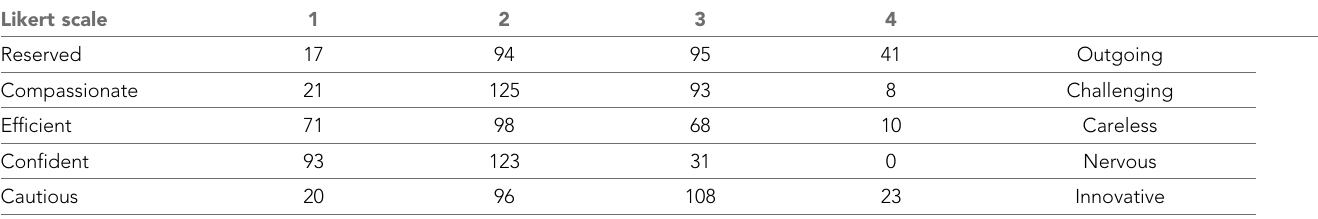
Table 2. Personality traits of the responders, n ( N = 247) Likert scale